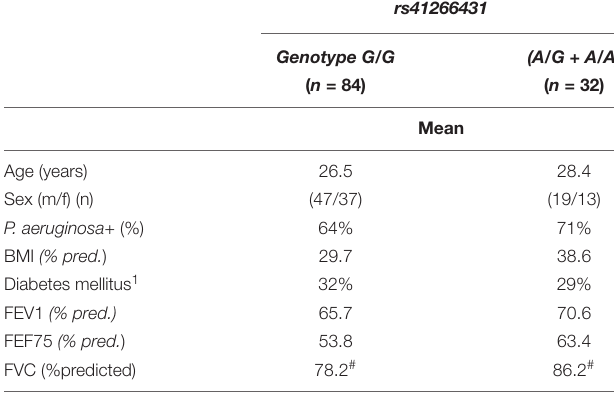
TABLE 2 | Patients